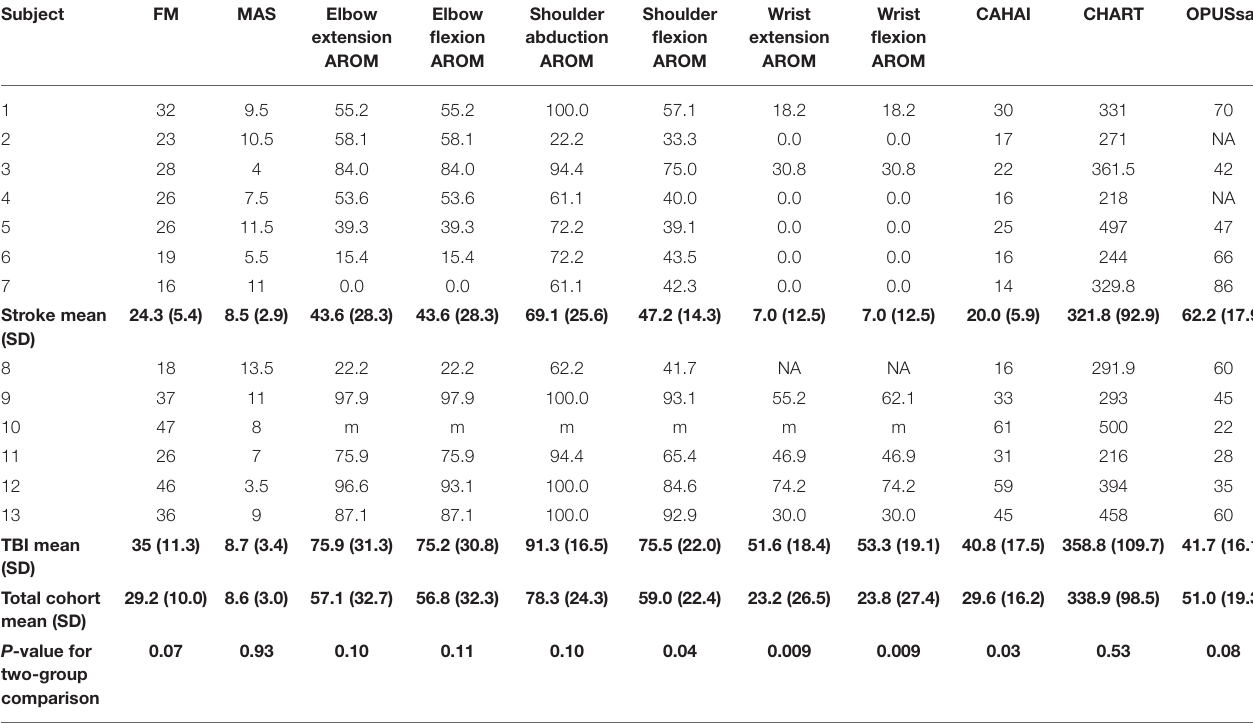
TABLE 2 | Baseline outcome measure